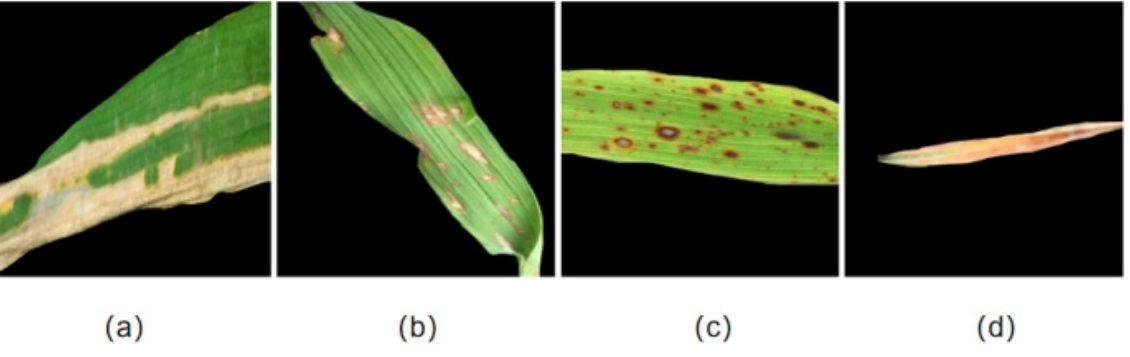
Figure 2. SBG-Dataset images ( a ) Bacterial blight; ( b ) Blast; ( c ) Brown spot; ( d ) Tungro.